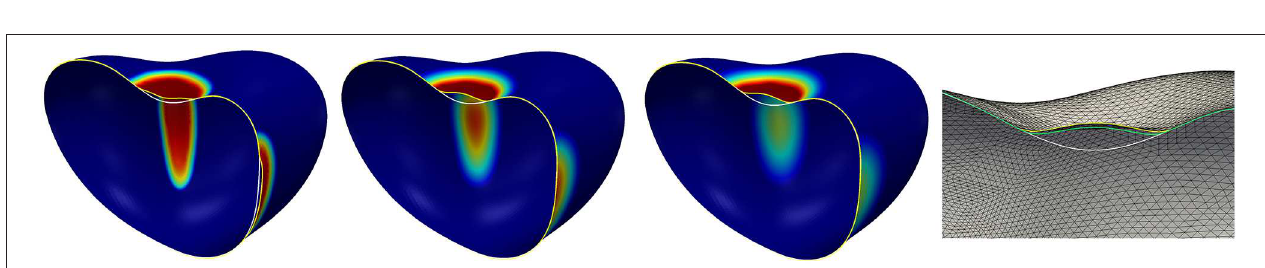
FIGURE 11 | The left three figures show the surface evolution at times t 0.25,1.25,5 for the model in section 5.5 with the parameters given in Table 3 but with = d f 0.01, i.e., a reduction of the diffusivity of the signal to 1 % of its original value in the region where the linkers are not broken. The color corresponds to the signal = strength and is the same as in Figure 10 . The shape at the final time T 5 is a stationary state. The figure on the very right displays slices through the shapes at the = final time T 5 for two different grid resolutions and time steps. The yellow curve is the stationary state corresponding to the left three figures, i.e., using around = 40 000 element and a time step of 0.001. The green curve corresponds to the final state on 160 000 elements and with a time step of 0.0005. As before, the white curve shows the initial surface. The final deformed surface with the coarser triangulation also serves to give an impression of the grid resolution compared to the size of the developed bleb.